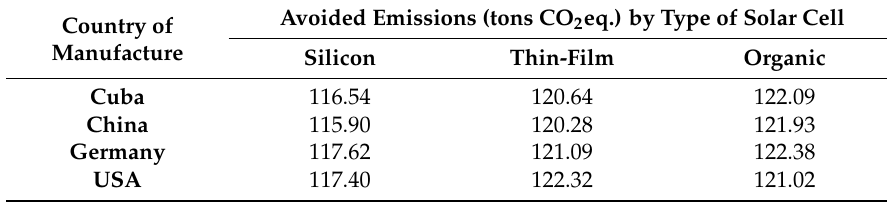
Table 5. Potential avoided CO 2 emissions of a 5.4 kWp SHS installation in Cuba, by country of manufacture.